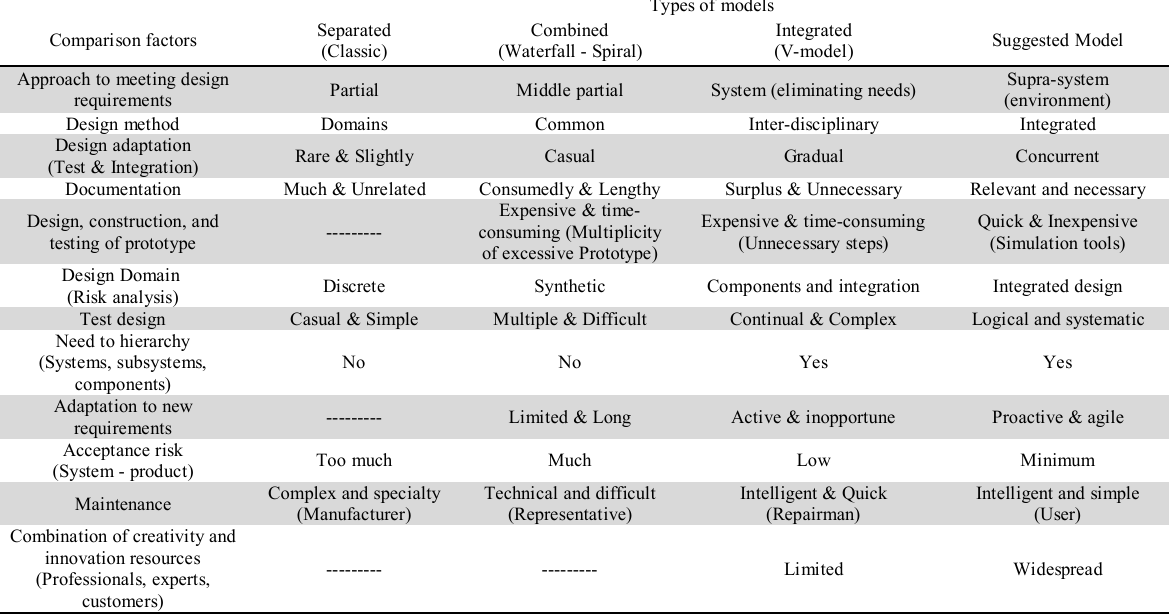
Comparison of existing models for determining the features of the proposed model (Seyedhosseini & Keyghobadi,2010)